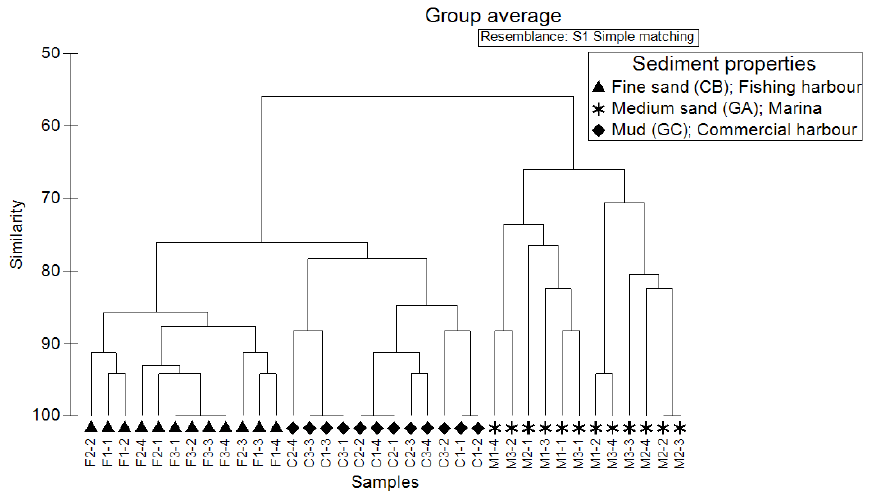
Figure 2. Cluster dendrogram showing three distinct subgroups of stations (GA, GB, and GC) ac- cording to the sediment characteristics of 36 samples (12 replicates for each harbour).